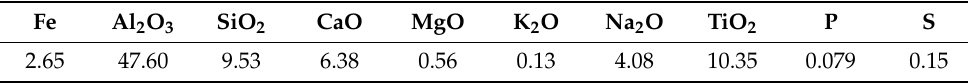
Table 3. Occurrence of alumina and silica in the SSS (%).